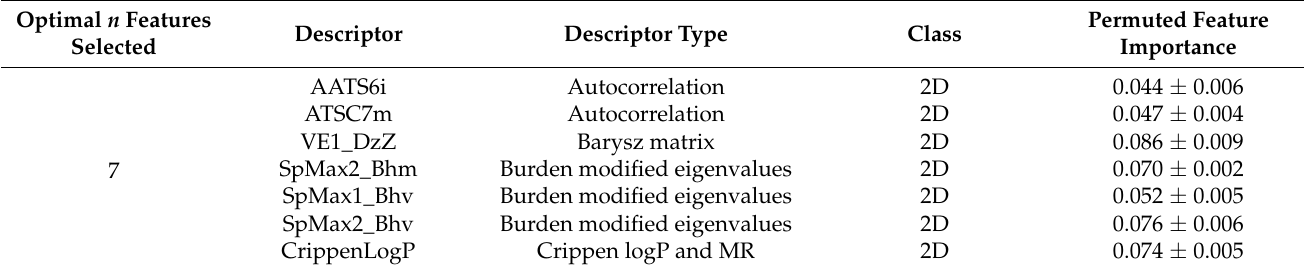
Table 4. Feature selection analysis of the selected molecular descriptors of the best classification model developed. Permuted feature importance score is reported with the standard deviation. Optimal n Features